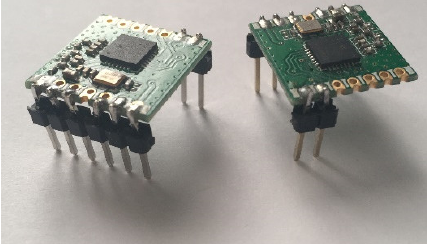
Figure 9. Photo showing two transceivers with a 1p coin .